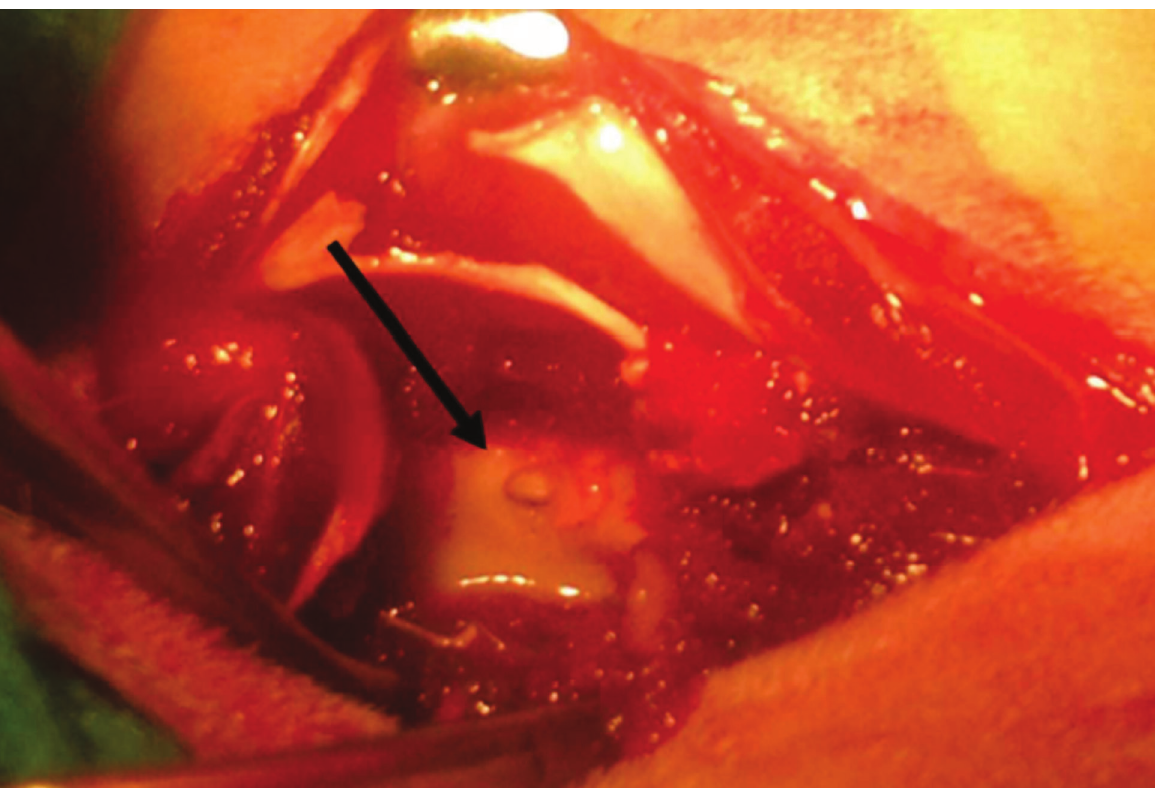
Figure 1 - Image after the completion of the dorsal laminectomy for accessing the spinal canal and visualization of the spinal cord (black arrow). Source: personal archive,